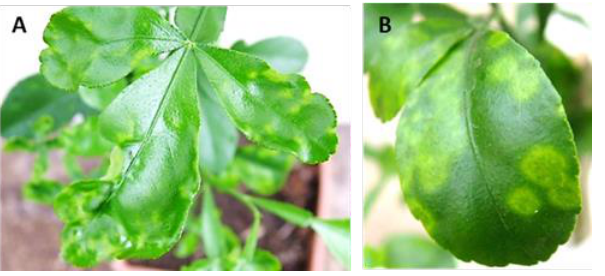
Figure 8. Symptoms of citrus tatter leaf on young ( A ) and mature ( B ) leaves of Carrizo citrange